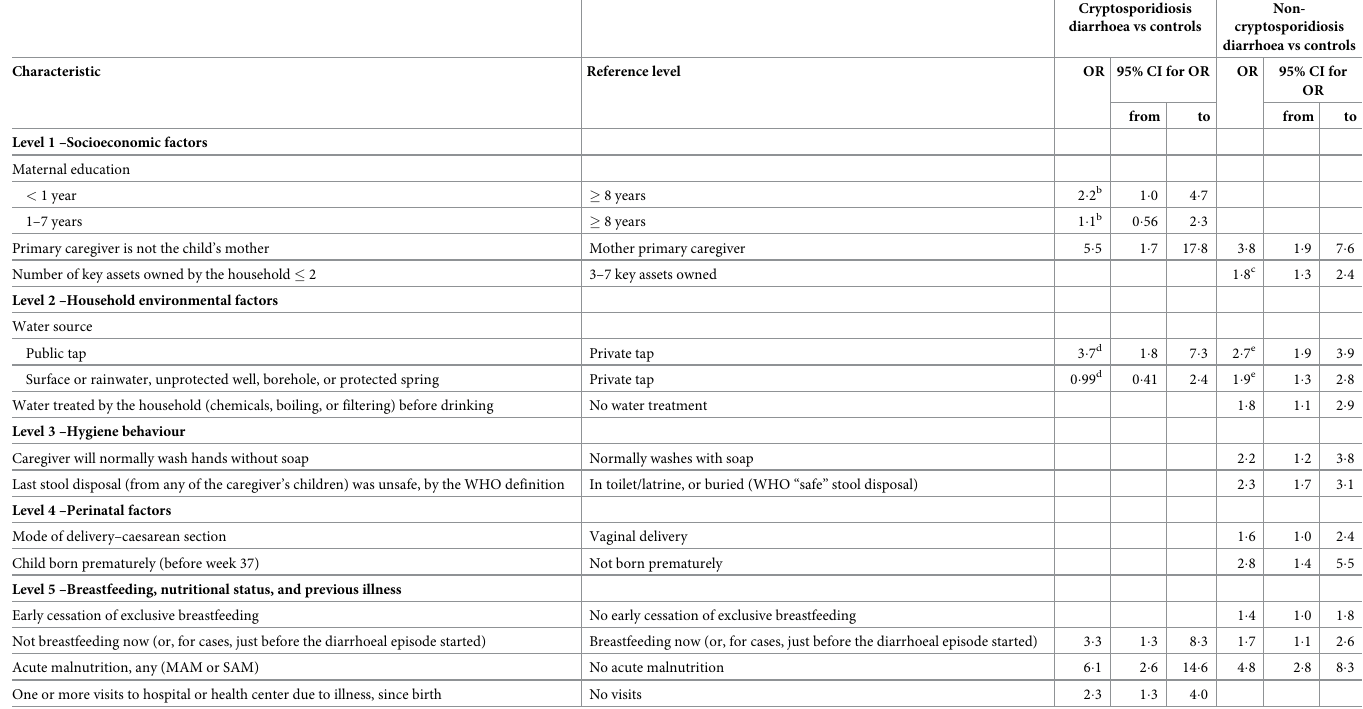
Table 3. Risk factors for cryptosporidiosis diarrhoea and non-cryptosporidiosis diarrhoea in children under 2-years old, compared with non-diarrhoea controls; odds ratios estimated from separate intra-level multivariable regression models a